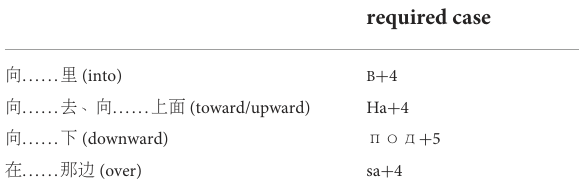
TABLE 2 A comparison of the corresponding relationship between the Chinese preposition “ 向 ” structure and Russian prepositions. Chinese “ 向 ” preposition structure